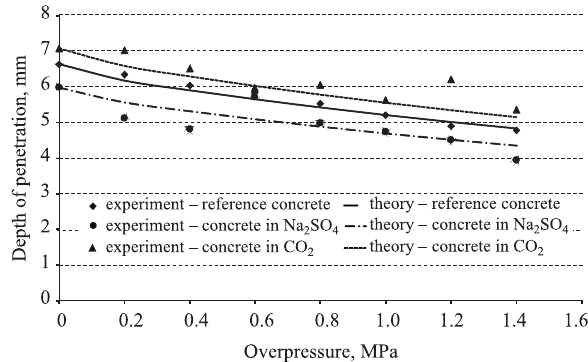
Fig. 3. Graphical presentation of results – depth of water jet penetration relationship on the overpressure in the vessel for two extreme concrete samples and the reference one (curves are calculated from theory and the value at zero overpressure)